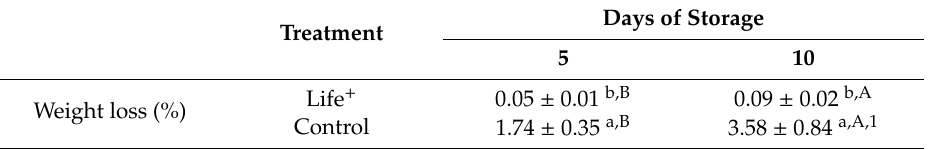
Table 2. Weight loss of strawberries stored at 6 ◦ C for 15